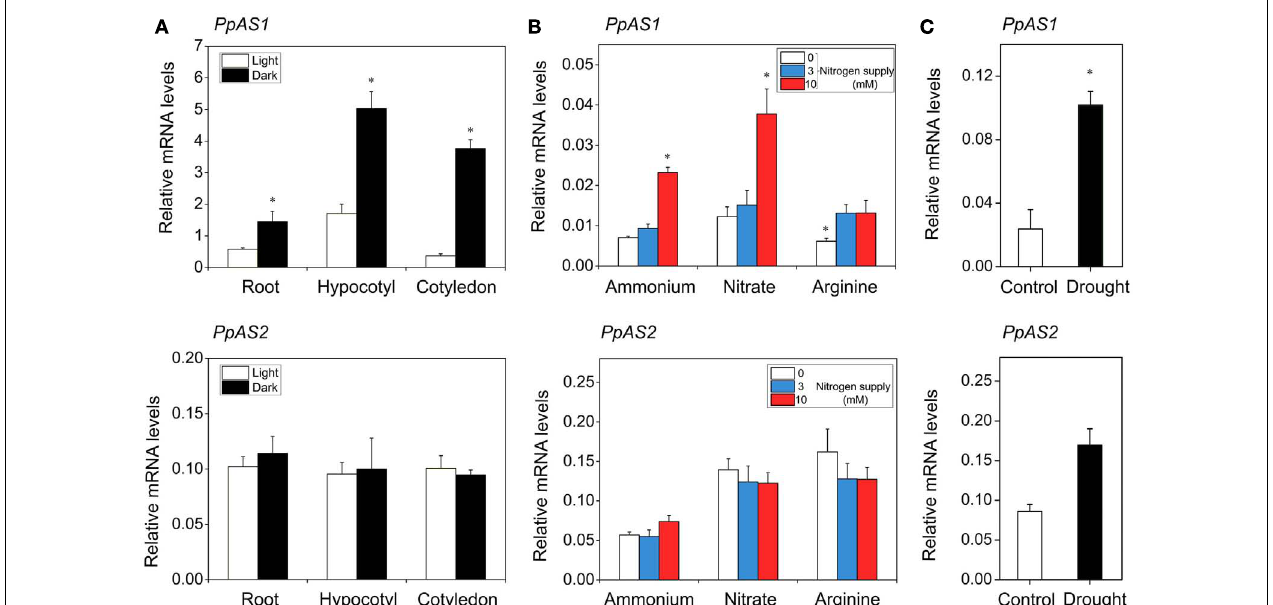
(ammonium, nitrate, and arginine) and then transcripts levels of PpAS1 and PpAS2 were quantified by real-time qPCR. (C) PpAS1 and PpAS2 expression in roots of seedlings subjected to a drought period of 21days analyzed by real-time qPCR. Expression data were normalized using a geometric mean of three reference genes ( ACT , 40S , and EF1 α ). A Student’s t -test was performed to test the significance ( P ≤ 0.01) of the differences between treatments. Significant changes are indicated with an